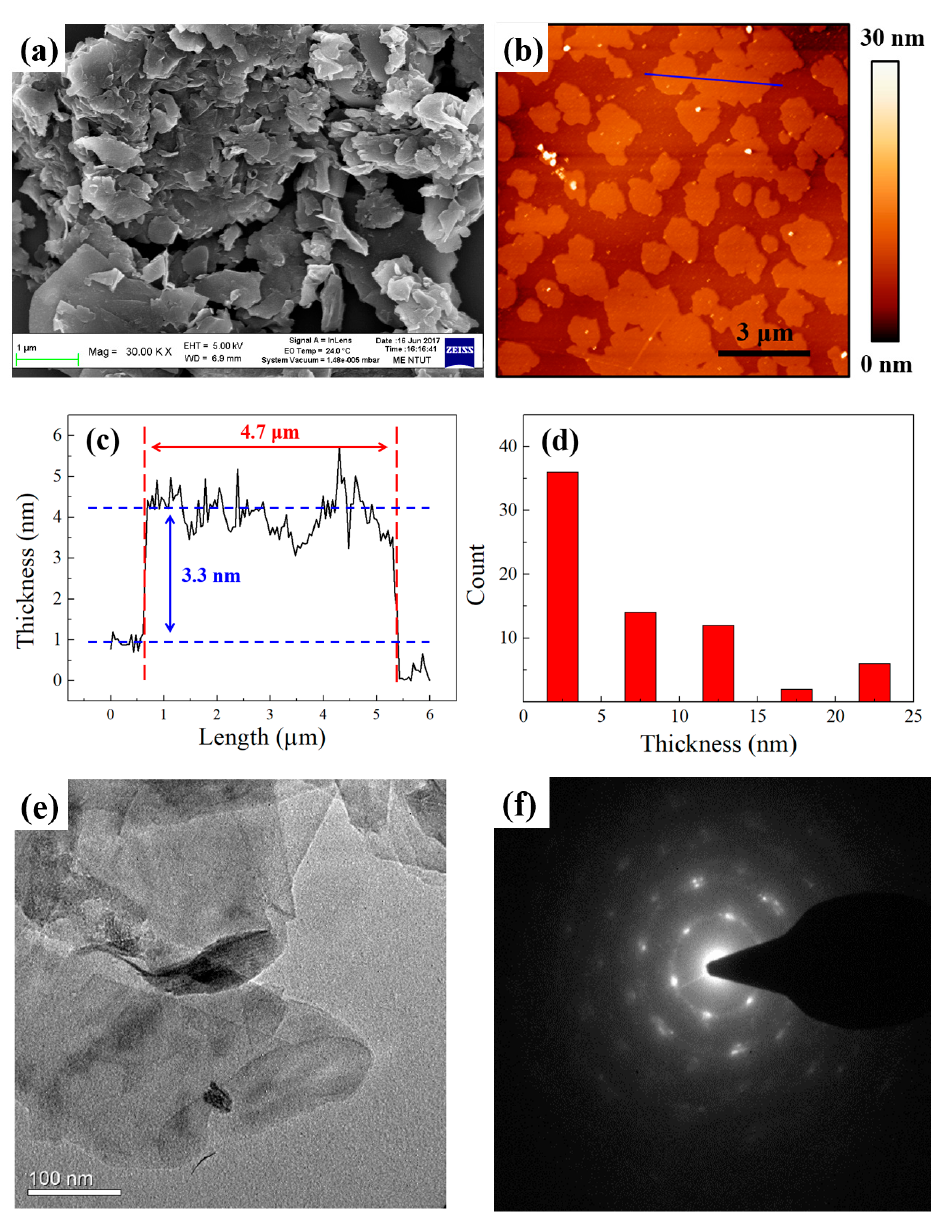
Figure 5. ( a ) SEM image of the GNFs; ( b ) AFM image of the GNFs; ( c ) thickness profile of the GNFs; ( d ) thickness distribution map of the GNFs; ( e , f ) TEM image of the GNFs and their SAED pattern.